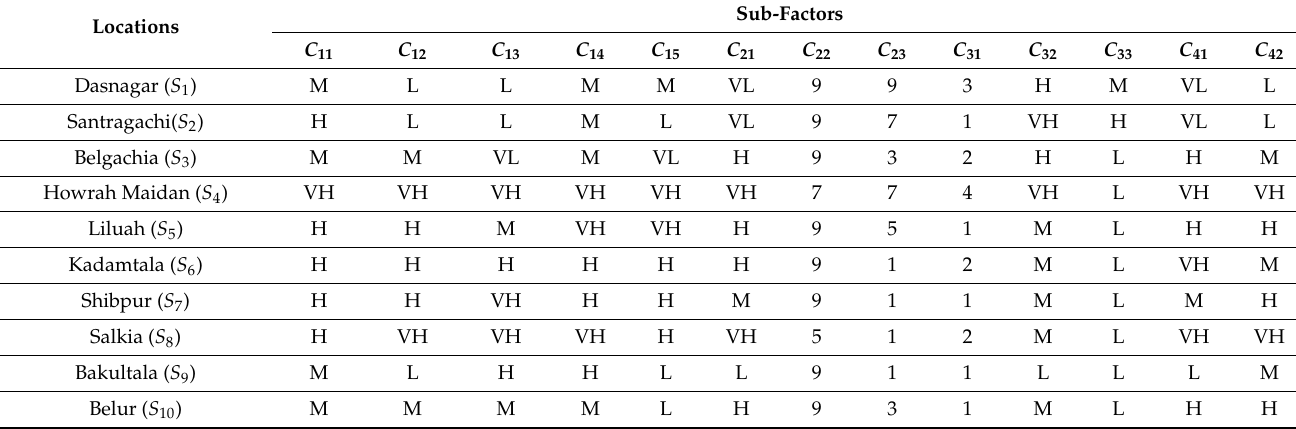
Table 9. Comparison analysis in linguistic variables for preference of alternatives with respect to sub-factors.